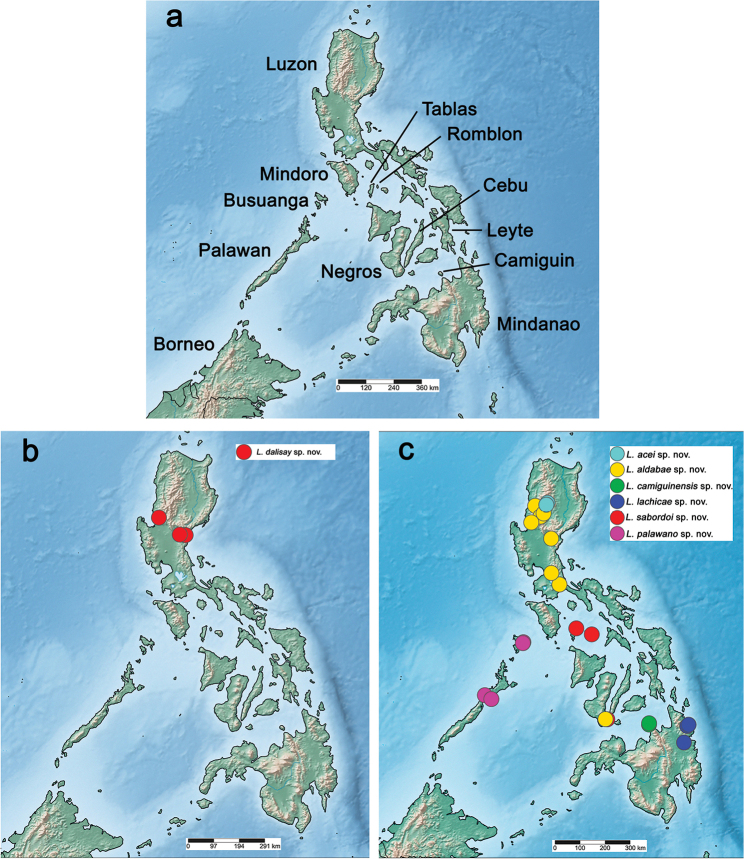
Distribution of Labiobaetis in the Philippines a Philippines, overview b Group dendrisetisc Group numeratus.